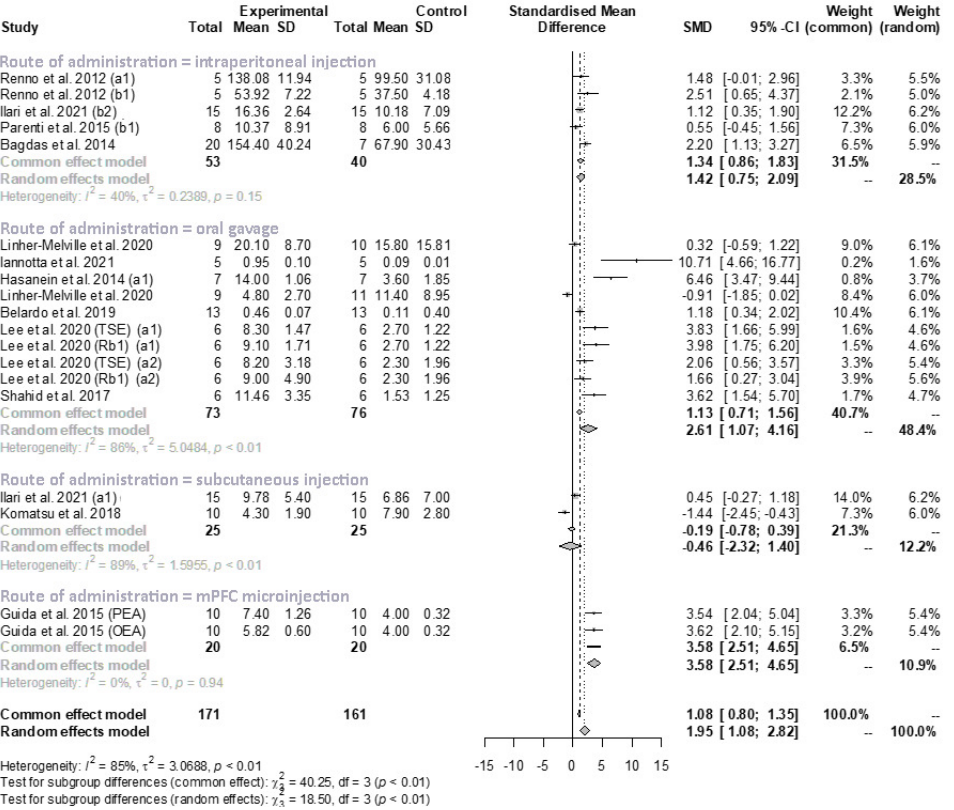
Figure 7. Forest plot showing the nutraceutical effects in the subgroup (route of administration) of mechanical allodynia/hyperalgesia by measuring the withdrawal threshold in the injured paw. SD, standard deviation; SMD, standardized mean differences; CI, confidence interval. In the meta-analysis of the pain model subgroup, we observed that neuropathic pain induced by chemotherapy or diabetic agents had a stronger effect (SMD: 4.7, 95% CI: 0.63 to 8.11) than that induced by injury of the sciatic nerve (SMD: 1.60, 95% CI: 0.72 to 2.48) (Figure 8). A high heterogeneity between studies was observed (I2 = 86.0%, p < 0.01 and I2 = 85.0%, p < 0.01, respectively) (Figure 8).